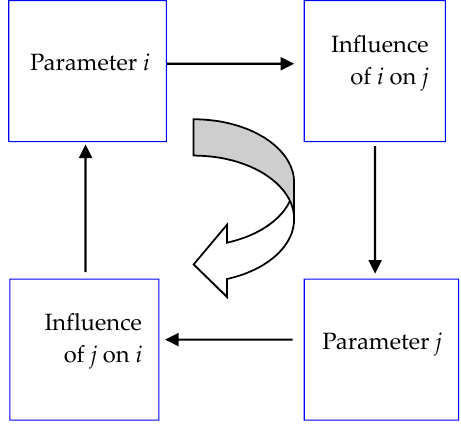
Figure 5. General illustration of the interaction matrix with two factors [28].